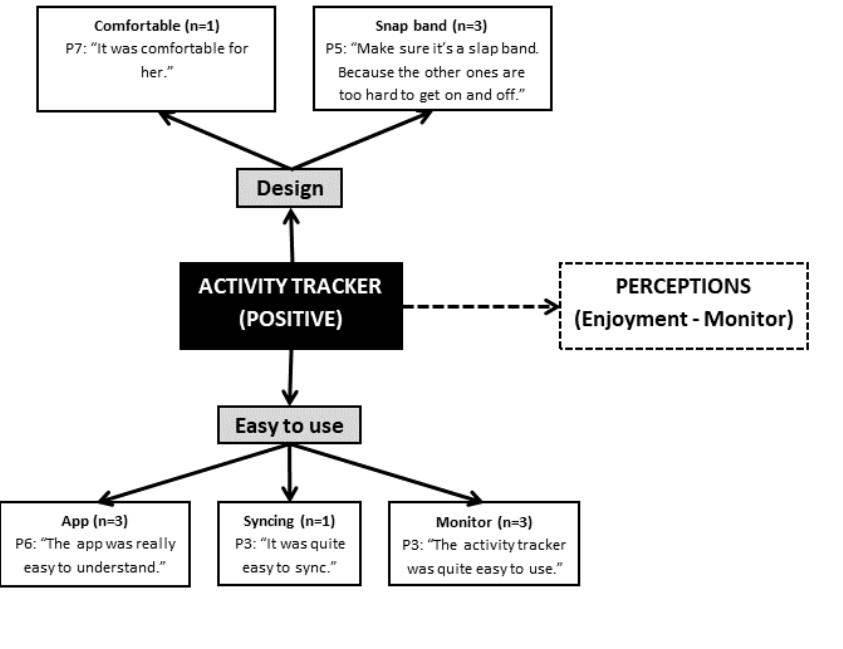
Figure 1. Positive perceptions of the wearable activity tracker. The dashed line indicates link made between different themes noted by the researchers from the points discussed, rather than directly mentioned by the parents